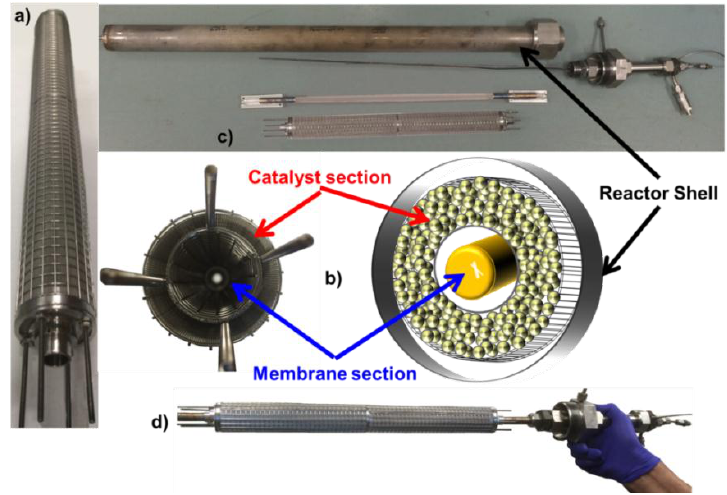
Figure 1. Cage, catalyst and membrane configurations used in this work: ( a ) assembled protective cage without a membrane; ( b ) cross-sectional view of the cage and its schematic representation; ( c ) different components of the catalytic membrane reactor (CMR) module; ( d ) integrated cage-catalyst-membrane